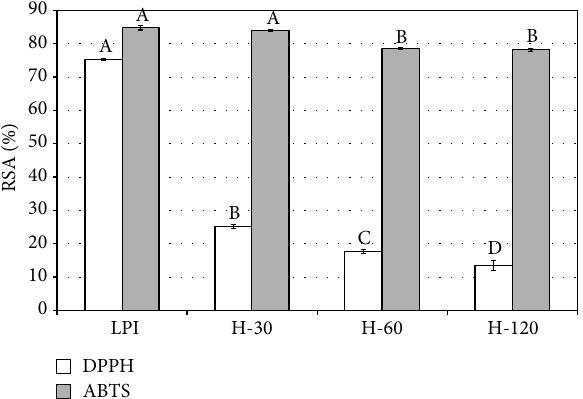
Figure 5: Antioxidant activity expressed as radical scavenging activity. The presented values are means ± standard deviations ( n = 3 ). Values with di ff erent letters (a – d) in plot bars for the same method di ff er signi fi cantly at P ≤ 0 : 05